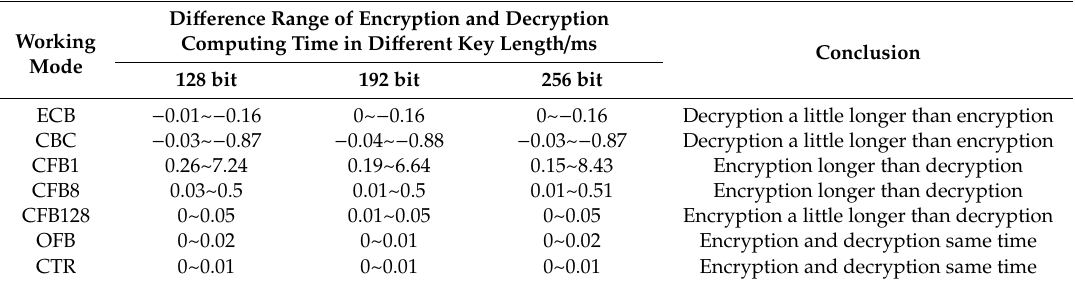
Table 1. Computing cost analysis and comparison of AES encryption and decryption.